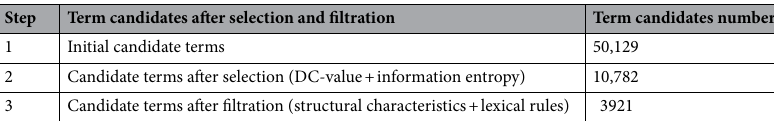
Table 2. The selection and filtration of candidate terms.